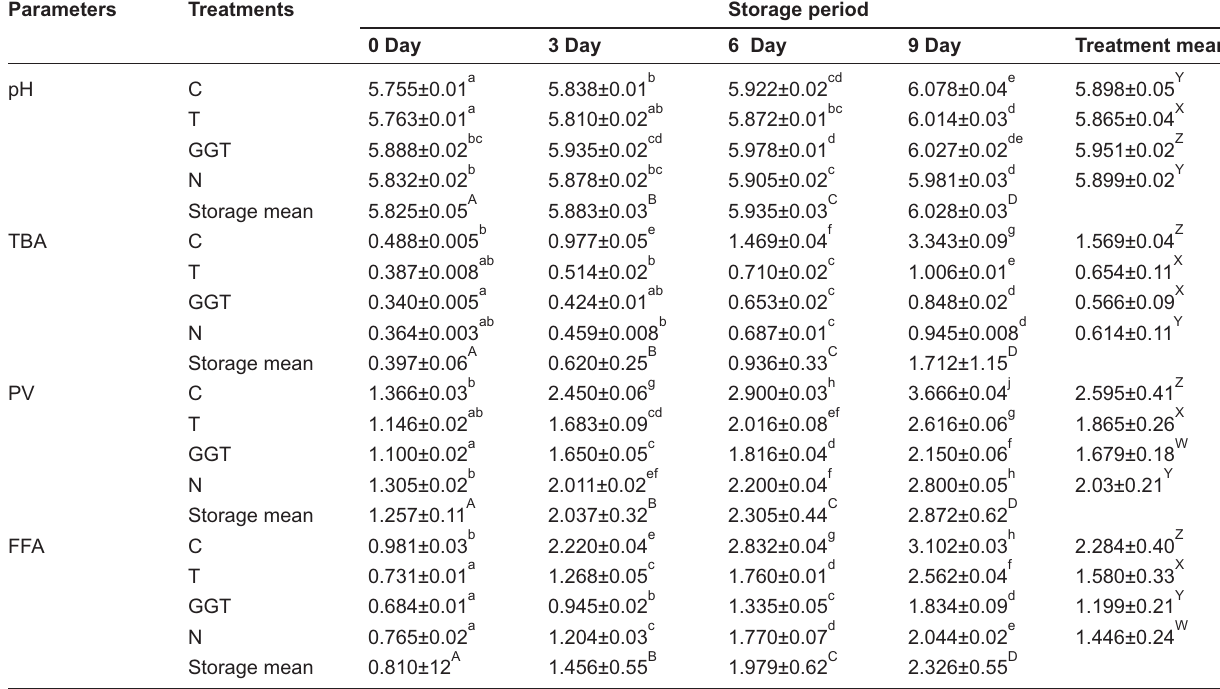
Table 1:- Mean±S.E. values of various physico-chemical properties for different treatments and storage period